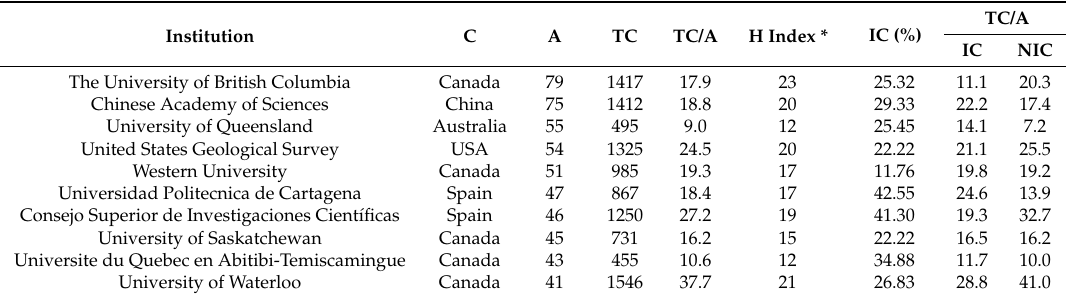
Table 5. Most productive institutions in MW